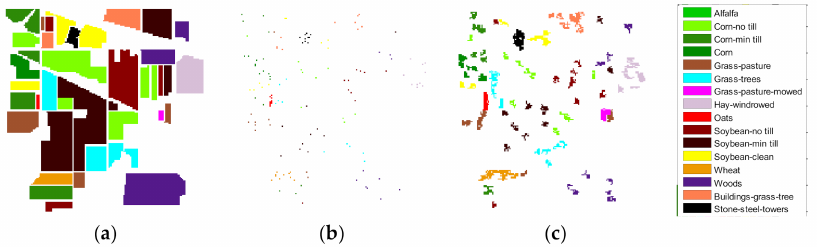
Figure 3. The Indian Pines data: ( a ) labeled image of Indian Pines data, ( b ) randomly selected samples, and ( c ) candidate samples of the same class.